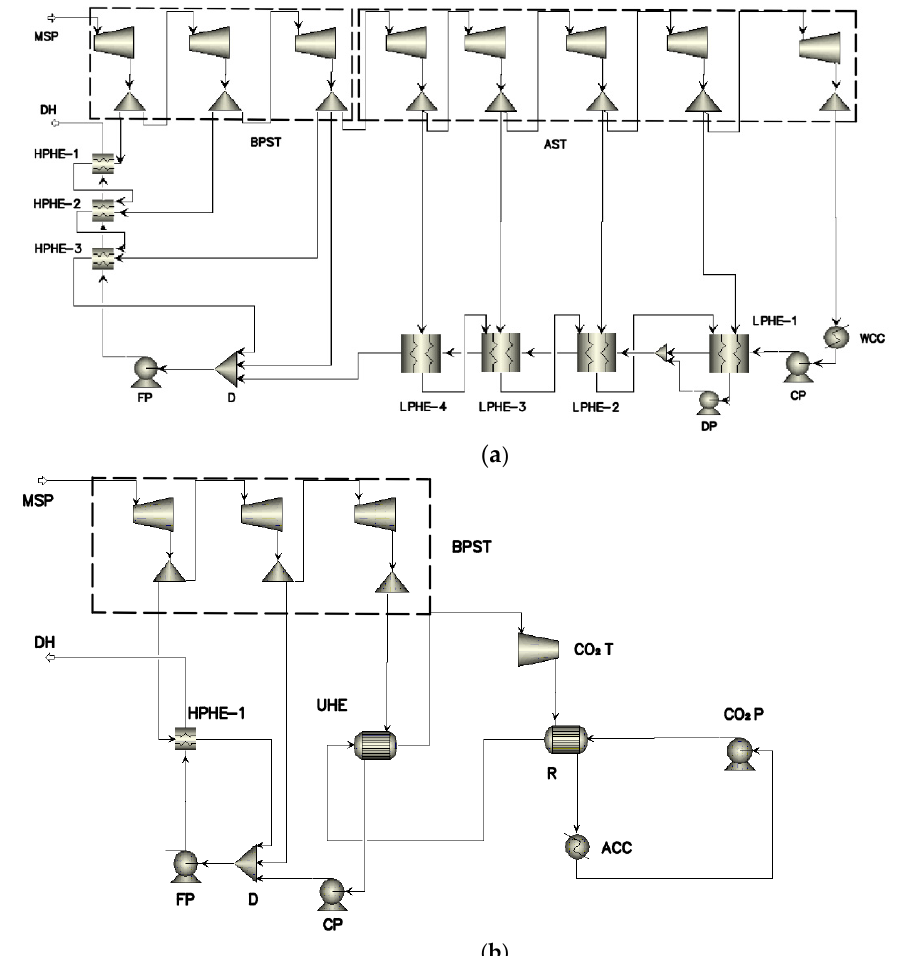
Figure 3. Simulation flow charts: ( a ) Case 2a, ( b ) Case 2b.